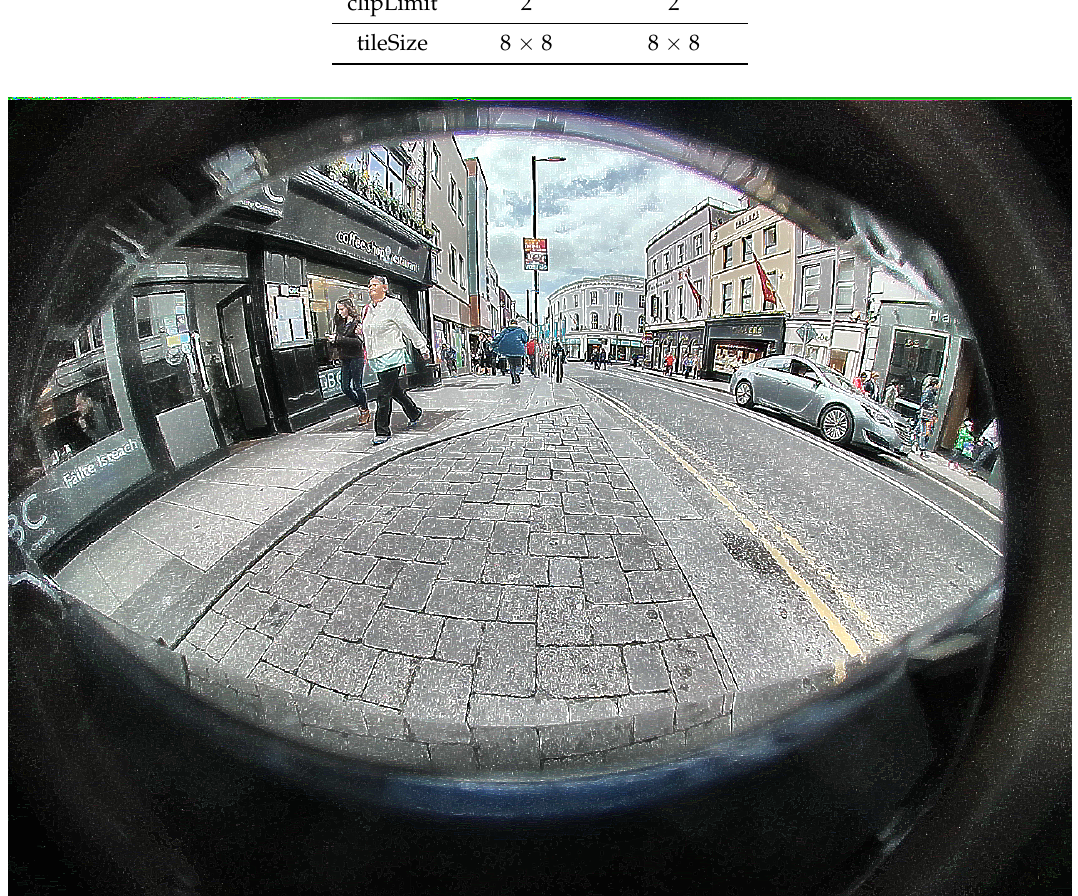
Figure 18. Image sharpened and contrasted using the parameters given by the best configuration found when sorted by compromise value (Lap8, clipLimit = 2 and tileSize = 8 ×